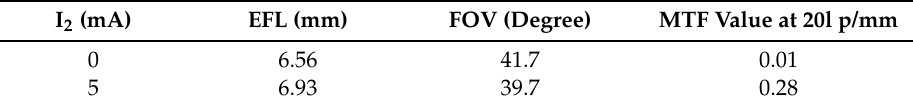
Table 4. Initial parameters of the zoom system.